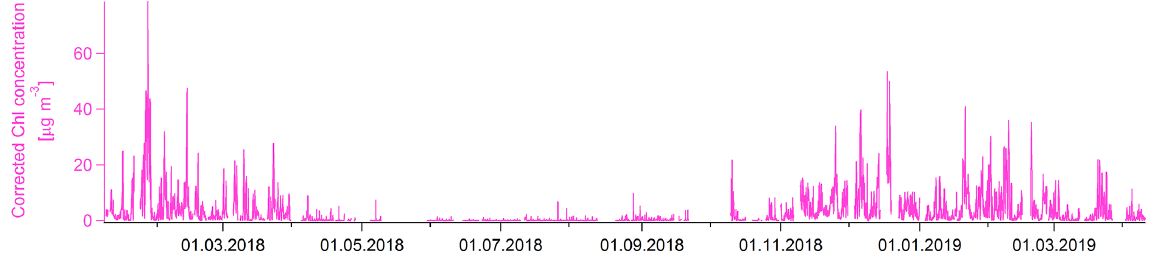
Figure 5. Time series of chloride after recalculation based on fragmentation table adjustments and RIE_Chl (cid:48) derived from NH 4 Cl